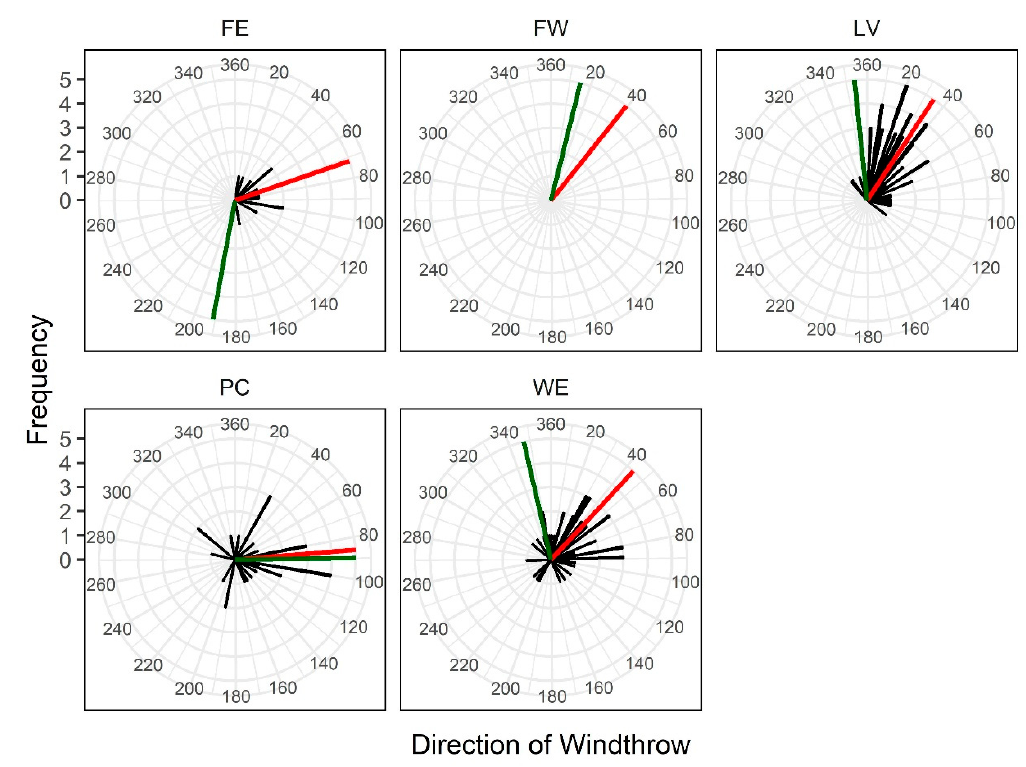
Figure 3. Circular histograms of windthrown trees at five harvest sites. Black bars: frequency of trees oriented at the respective azimuth. Red bars: mean azimuth of windthrow orientation. Green bars: mean azimuth of slope aspects as measured at the base of each stem. All FW tree bars match mean windthrow azimuth. (FE: Findlay East; FW: Findlay West; LV: Lavington; PC: Paturages; WE: West Elk). Table 4. Logit-scale coefficients for the best model for all dead trees (windthrow and snags) and windthrow only. All Dead